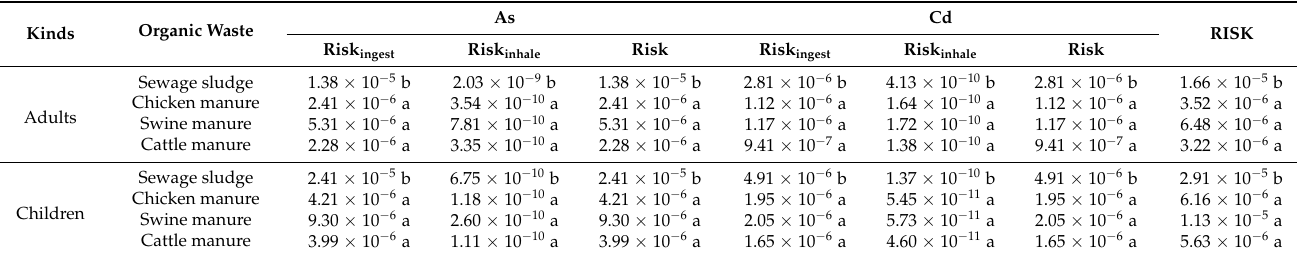
Table 7. Carcinogenic risk for adults and children due to environmental exposure to heavy metals in sewage sludge and livestock manure for agricultural